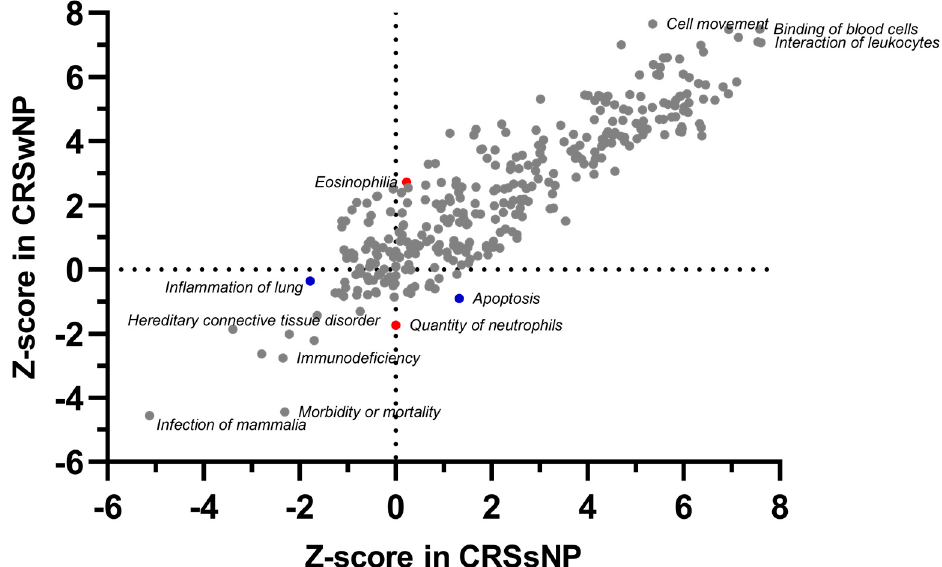
Figure 3. Comparison of enriched upstream regulators in CRSwNP and CRSsNP. The plot is based on the Z-score calculations obtained for a given set of genes, using the IPA analysis. A positive Z-score represents strongly activated (Z-score > 2) pathways, and a negative Z-score represents significantly inhibited (Z-score < − 2) pathways. Proposed unique phenotype-associated pathways are presented in red ( • ) for CRSwNP and in blue ( • ) for CRSsNP. Details in Supplementary Table S3 (Canonical pathways).